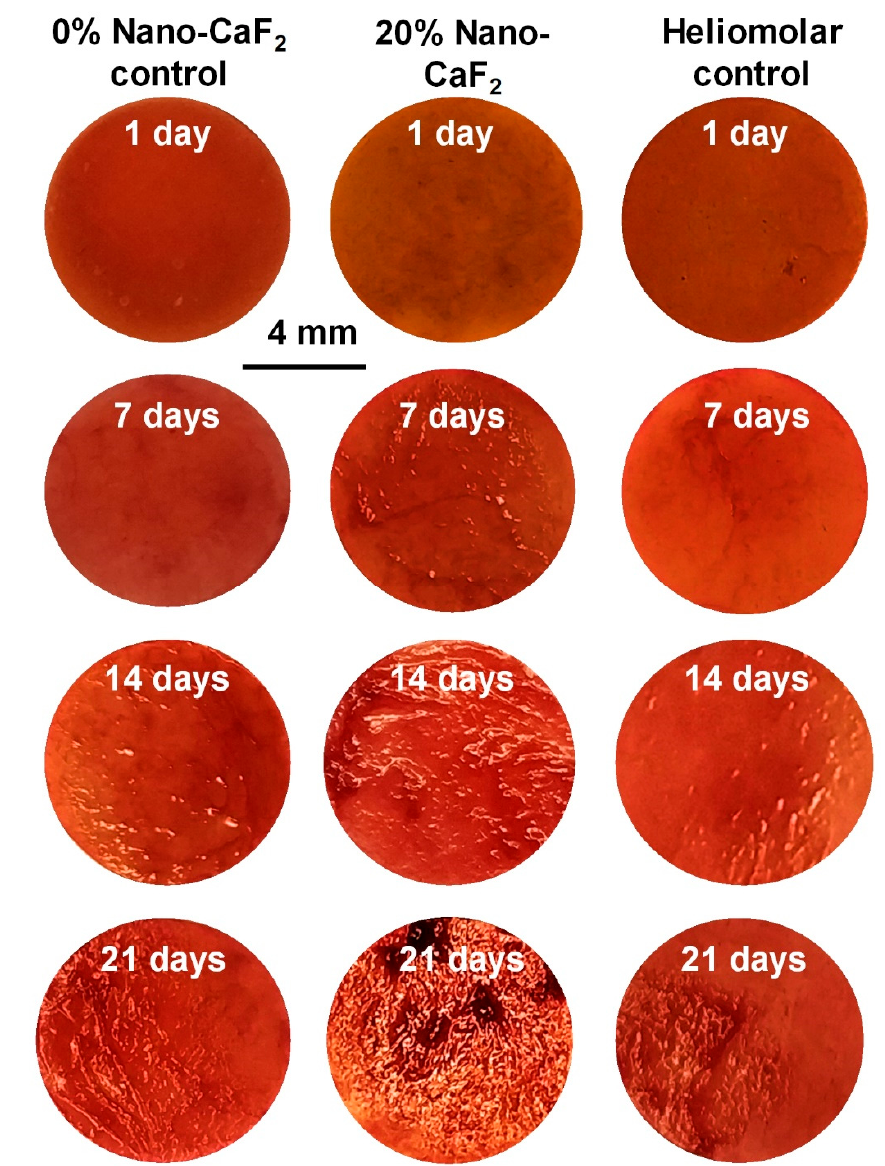
Figure 8. Representative ARS images of hPDLSC-synthesized bone mineral nodules (stained red). For 20% Nano-CaF 2 , bone mineral nodules started to appear at 7 days and increased at 14 days. The disks were covered by a layer of new mineralized bone matrix formed by hPDLSCs, which grew thicker with greater abundance at day 21. In contrast, there were much less mineral nodules on 0% Nano-CaF 2 and Heliomolar control (n = 6).